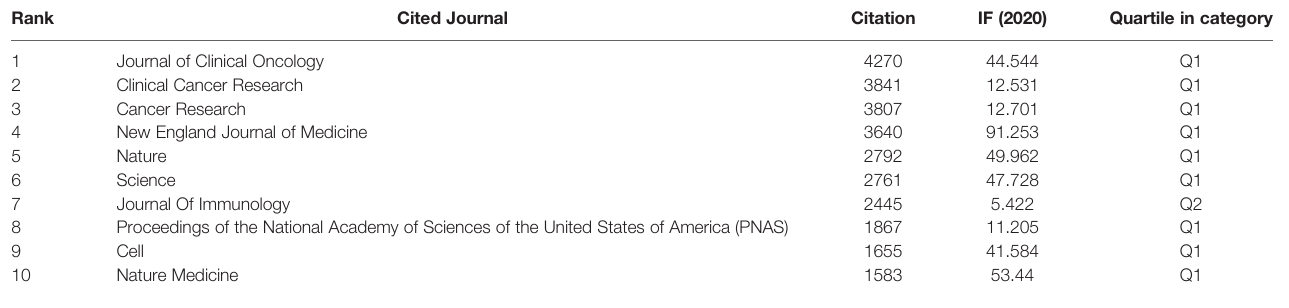
TABLE 4 | The top 10 co-cited journals associated with colorectal cancer immunotherapy.